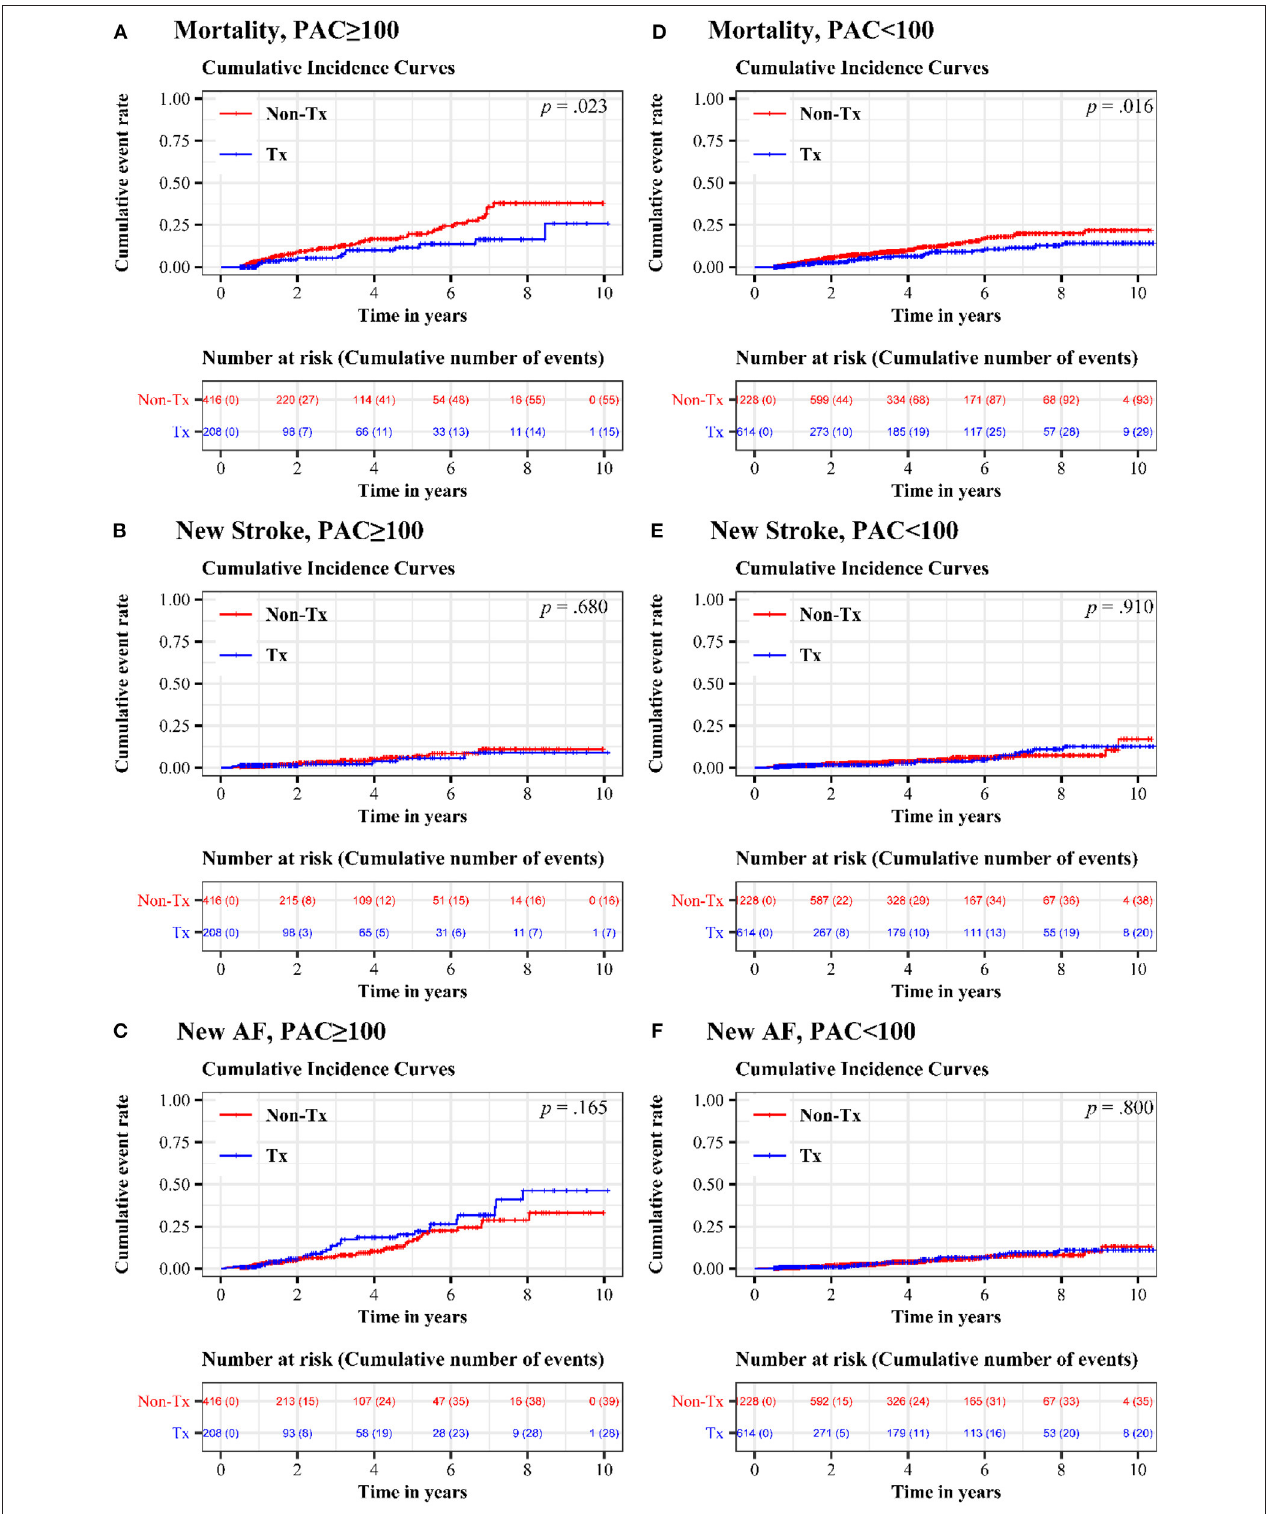
FIGURE 2 | Cumulative incidence of mortality, new stroke, and new AF in treatment and non-treatment groups. In the high-burden sub-cohort, comparison of (A) long-term all-cause mortality (B) long-term cumulative new stroke rate and (C) long-term cumulative new onset rates of AF were exhibited. In the low-burden sub-cohort, (D) long-term all-cause mortality (E) long-term cumulative new stroke rate and (F) long-term cumulative new onset rates of AF were shown. AF, atrial fibrillation; PAC, premature atrial complex.